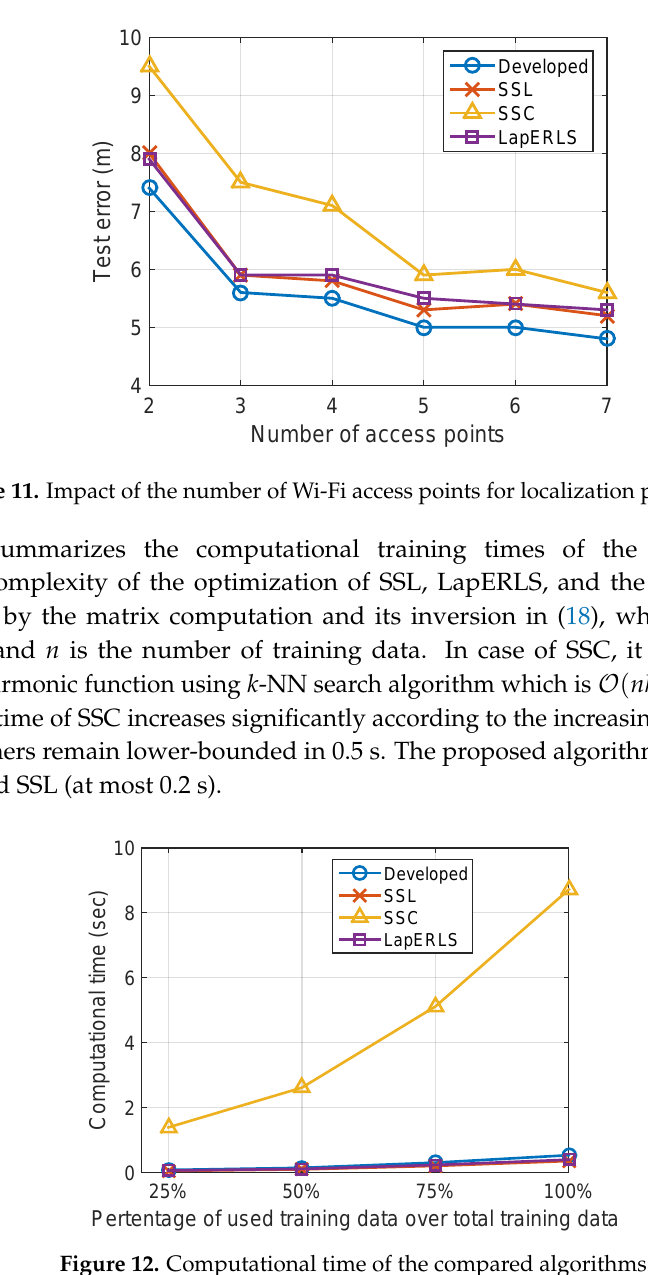
Figure 12. Computational time of the compared